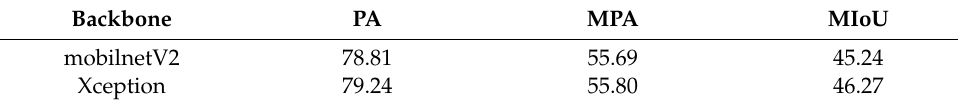
Table 5. The comparisons of performance with different